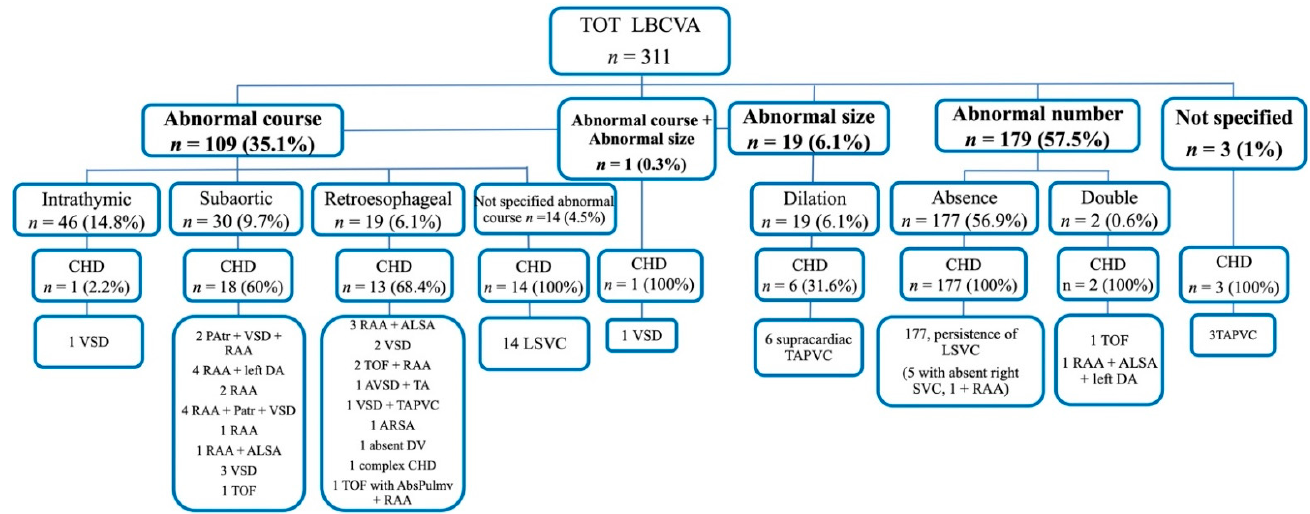
Figure 2. Number and percentage (%) of LBCVA (left brachiocephalic vein anomalies) and CHD (congenital heart defects) associated. LBCVA = left brachiocephalic vein anomalies; CHD = congenital heart defects; VSD = ventricular septal defect; RAA = right aortic arch; PAtr = pulmonary atresia; DA = ductus arteriosus; ALSA = aberrant left subclavian artery; TOF = tetralogy of Fallot; AVSD = atrioventricular septal defect; TA = truncus arteriosus; AbsPulmv = absent pulmonary valve; TAPVC = total anomalous pulmonary venous connection; ARSA = aberrant right subclavian artery; DV = ductus venosus; LSVC = persistent left superior vena cava; SVC = superior vena cava.